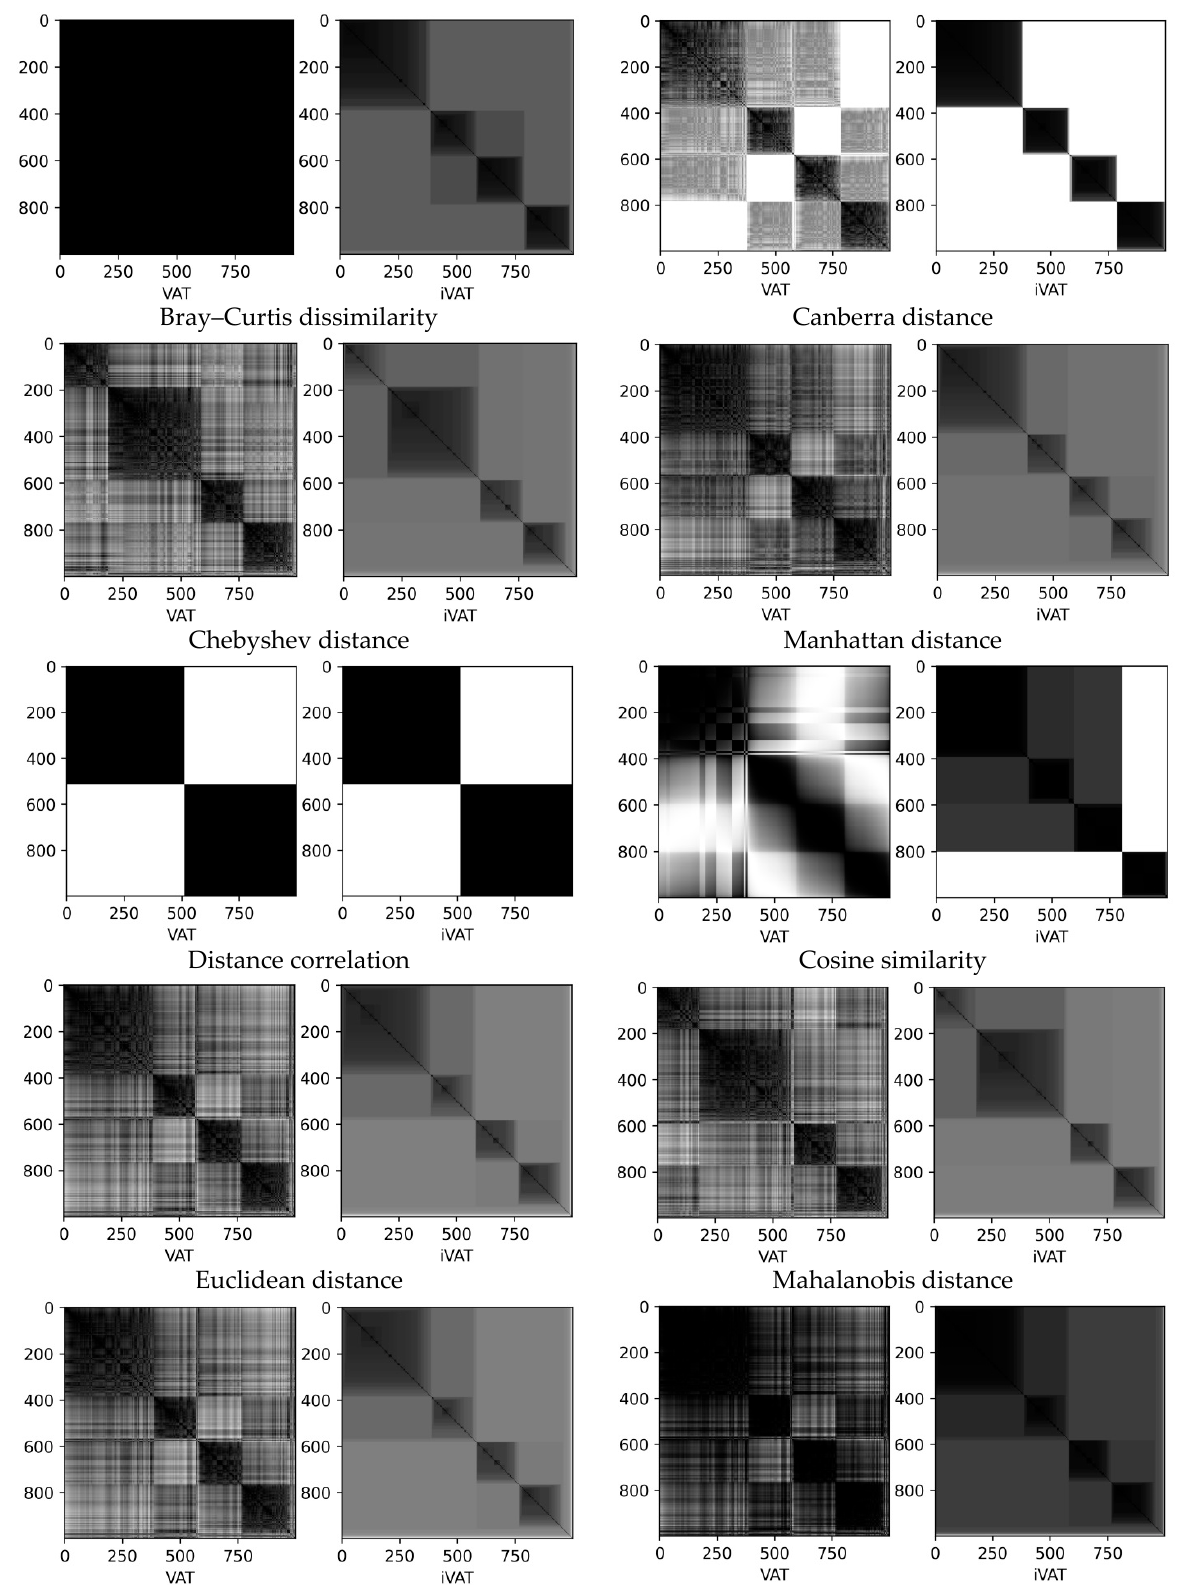
Figure A2. Sizes1. Cluster heat map.